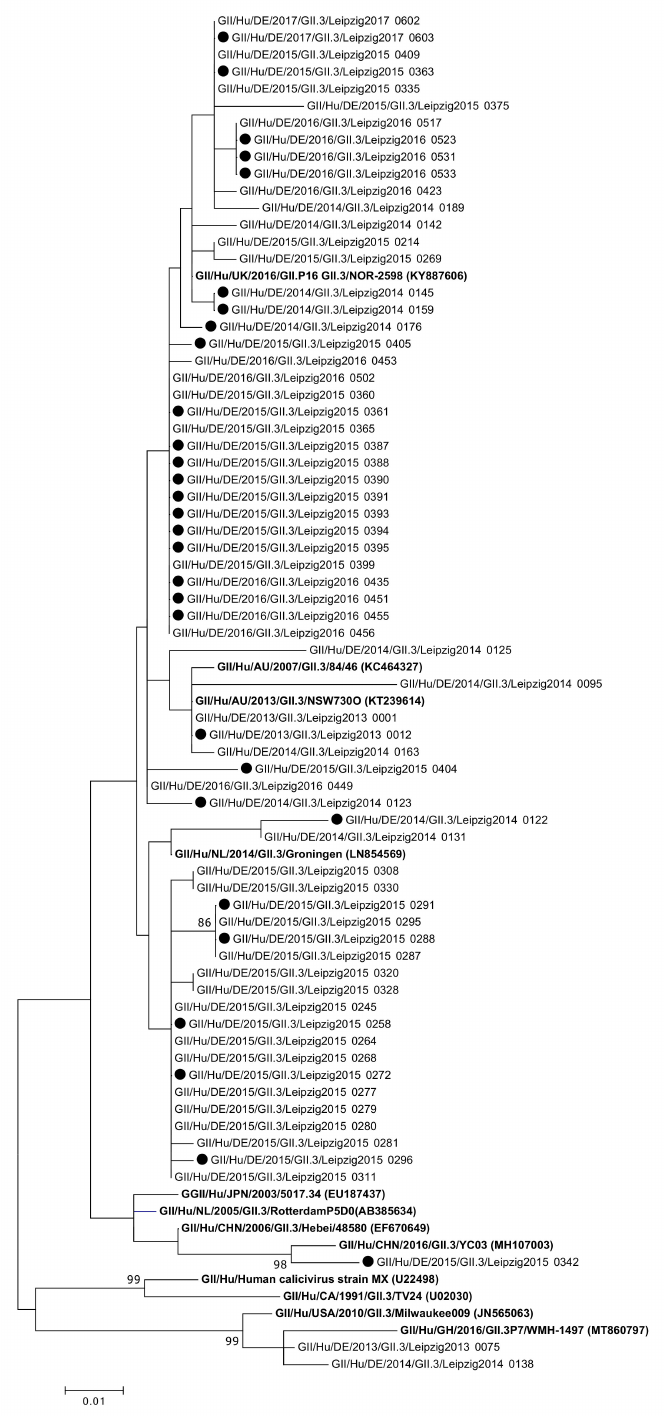
Figure 4. Phylogenetic analysis of norovirus GII.3 genotypes based on Maximum Likelihood